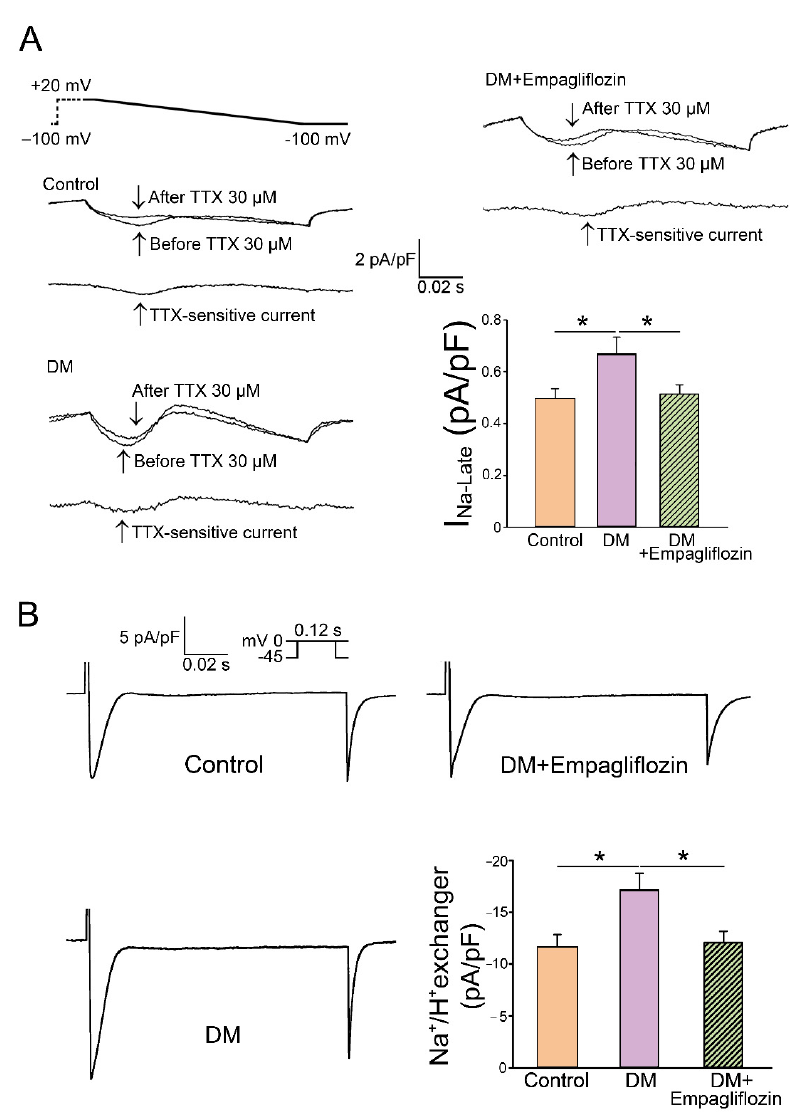
Figure 4. Modulation of late sodium current (I Na-Late ) and sodium hydrogen (Na + /H + ) exchanger current in empagliflozin-treated diabetic (DM) rats. ( A ) Representative tracing of current and average data of the I Na-Late from control ( n = 18 cells), DM ( n = 15 cells), and empagliflozin-treated DM (DM+ empagliflozin, n = 16 cells) rat ventricular myocytes. ( B ) Representative tracings of current and average data of the Na + /H + exchanger from control ( n = 17 cells), DM ( n = 18 cells), and DM + empagliflozin ( n = 19 cells) rat ventricular myocytes. * p < 0.05. (Adapted from the published article by Lee et al. [10].)